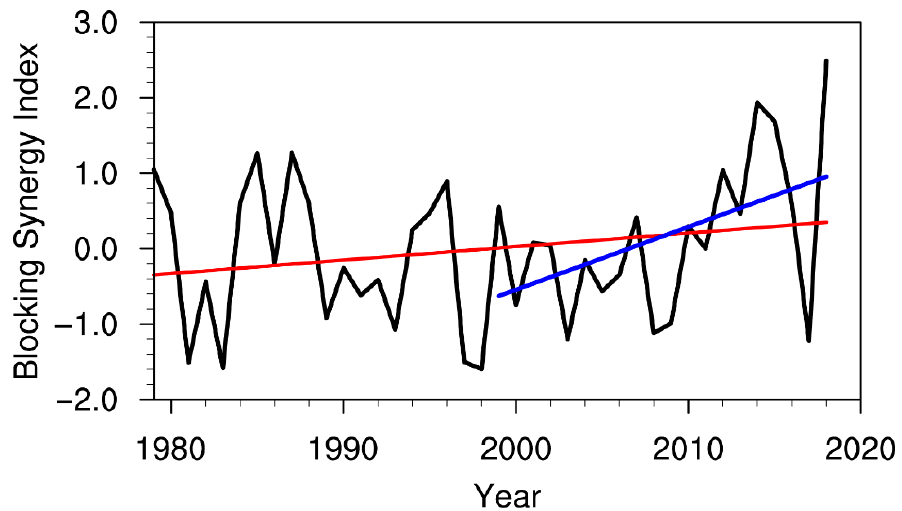
Figure 10. Time series of the standardized synergy index of blockings stretching into the Arctic (in the north of 66° N) for mid-January from 1979 to 2018. The red straight line is the trend line of 40 years, 0.018/year; the blue straight line is the trend line of recent 20 years, 0.083/year. See text for the details.